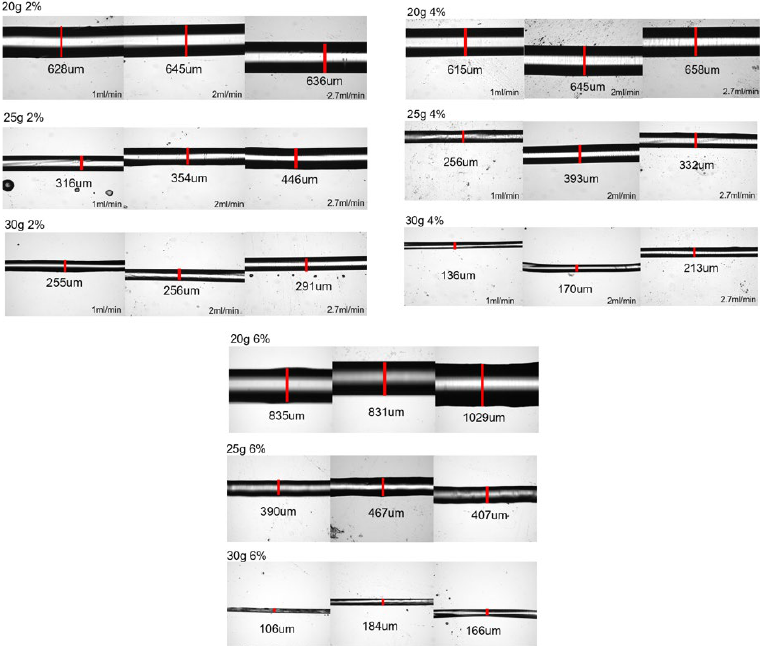
Figure 2. Optical pictures of the produced fibers. The images of the fibers are grouped into the sets of pictures of fibers made from sodium alginate of 2 wt%, 4 wt%, and 6 wt% where each row of images presents the results of spinning with a different needle gauge (of 20 g, 25 g, and 30 g, respectively). In each set of three sequential pictures, these images represent the increase in the volumetric flow rate from 1 mL/min to 2 mL/min to 2.7 mL/min. The white regions on the images of most of the fibers do not mean that these are hollow fibers but are indicative of the fact that for larger fibers, top sections of the fiber are not in focus.